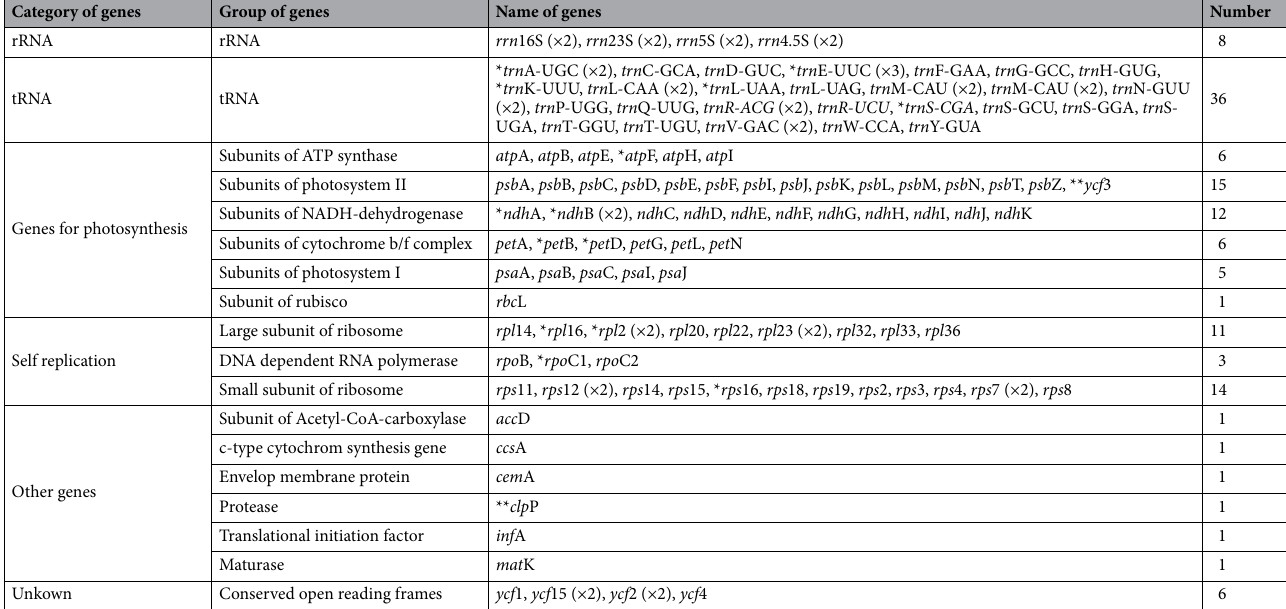
Table 2. List of genes present in the cp genome of the three cultivars of Scutellaria . *Gene with one intron; **gene with two introns.